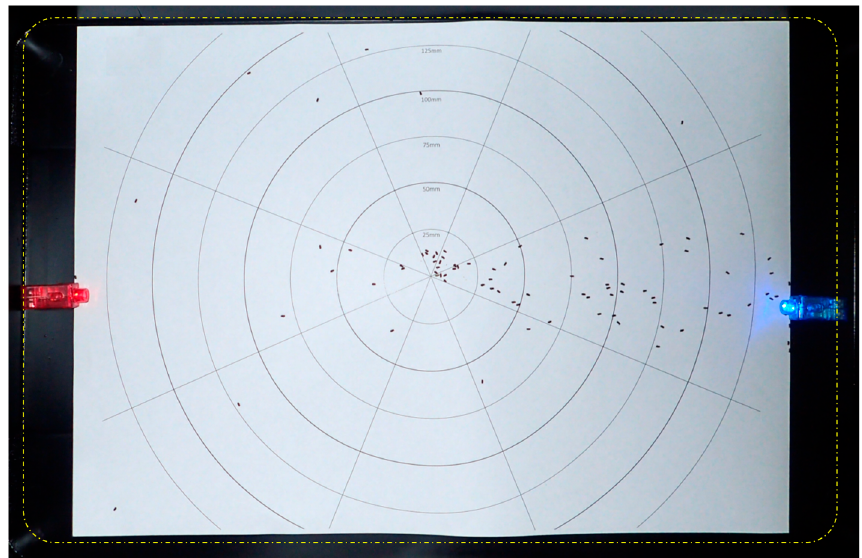
Figure 4. Example of recording (experiment #3, bi-color, replicate #3 in progress). Flash image taken 104 s after start. The dashed yellow line demarcates the flat base of the experiment container. Octant N is at the right.